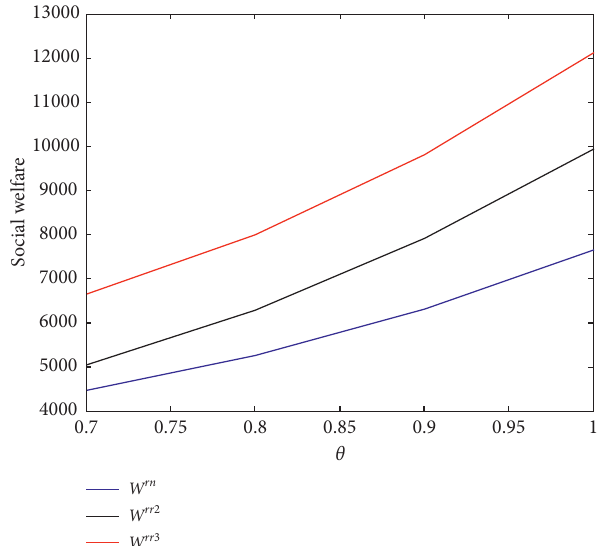
Figure 7: The social welfare under the retailer price cap regulation.